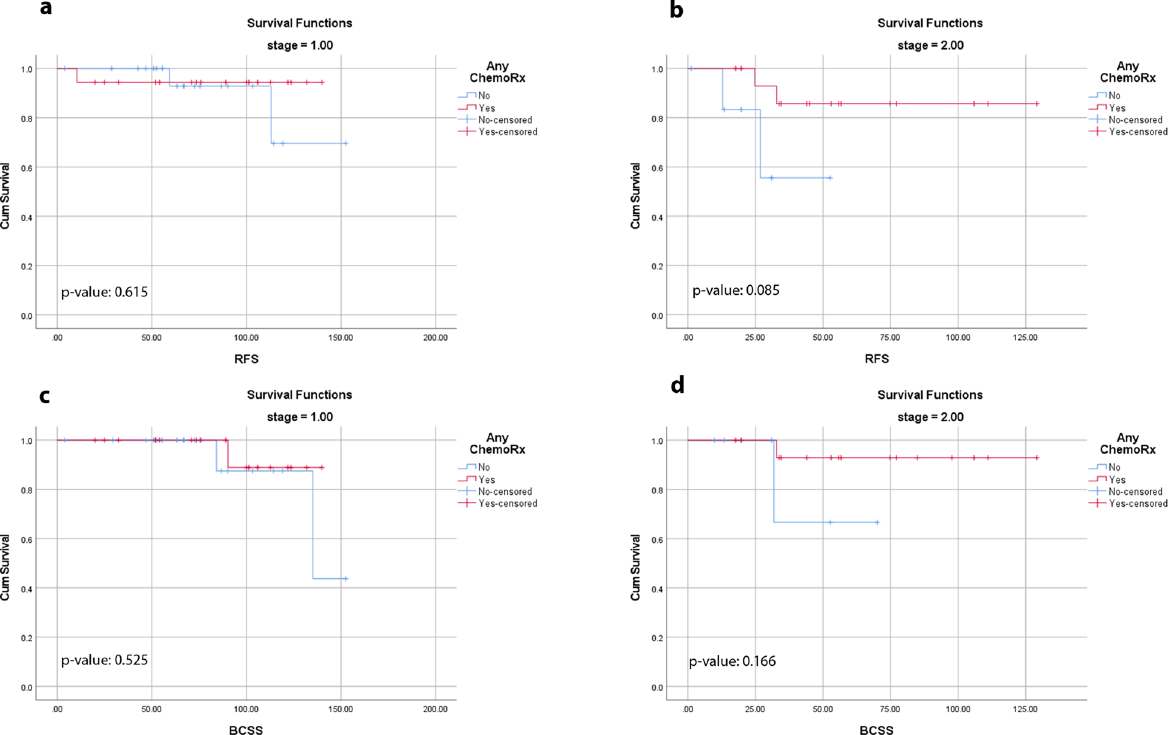
Fig. 2 Survival based on chemotherapy use in stage I and II patients. Recurrence-free (RFS) and breast cancer-speci fi c survival (BCSS) in stage-I and II patients based on whether they received chemotherapy or not ( a RFS in stage-I patients for chemotherapy, log-rank test p -value